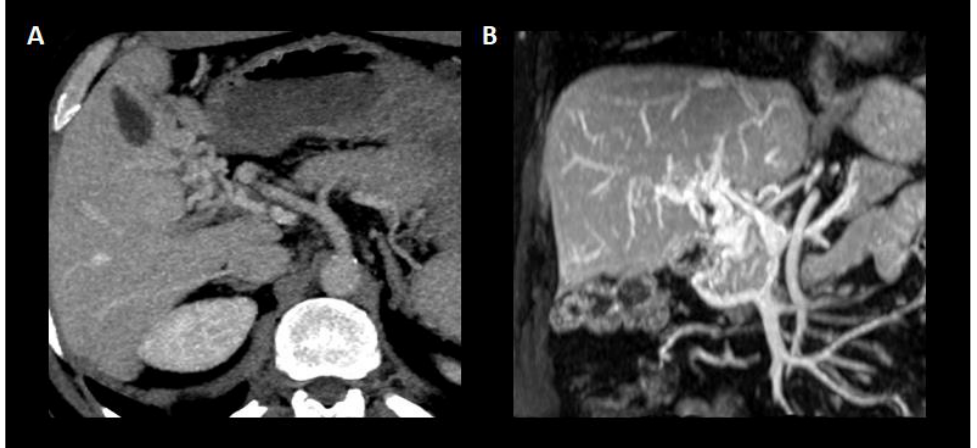
Figure 4. Cavernous transformation of the portal vein. ( A ) Axial plane showing the substitution of the main portal vein trunk by porto-portal collaterals originated from the vasa vasorum of the portal vein. ( B ) Coronal plane of the portal vein and its cavernous transformation with the entanglement of the new vessels composing the porto-portal collaterals.